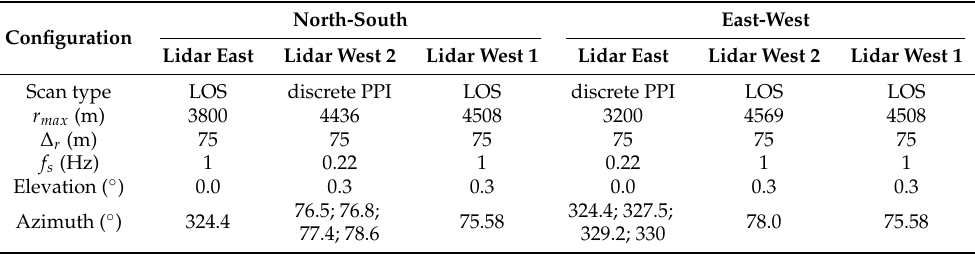
Table 3. Azimuth angles, elevation angles, maximal range r max and sampling frequency f s at which the wind data are recorded for each lidar